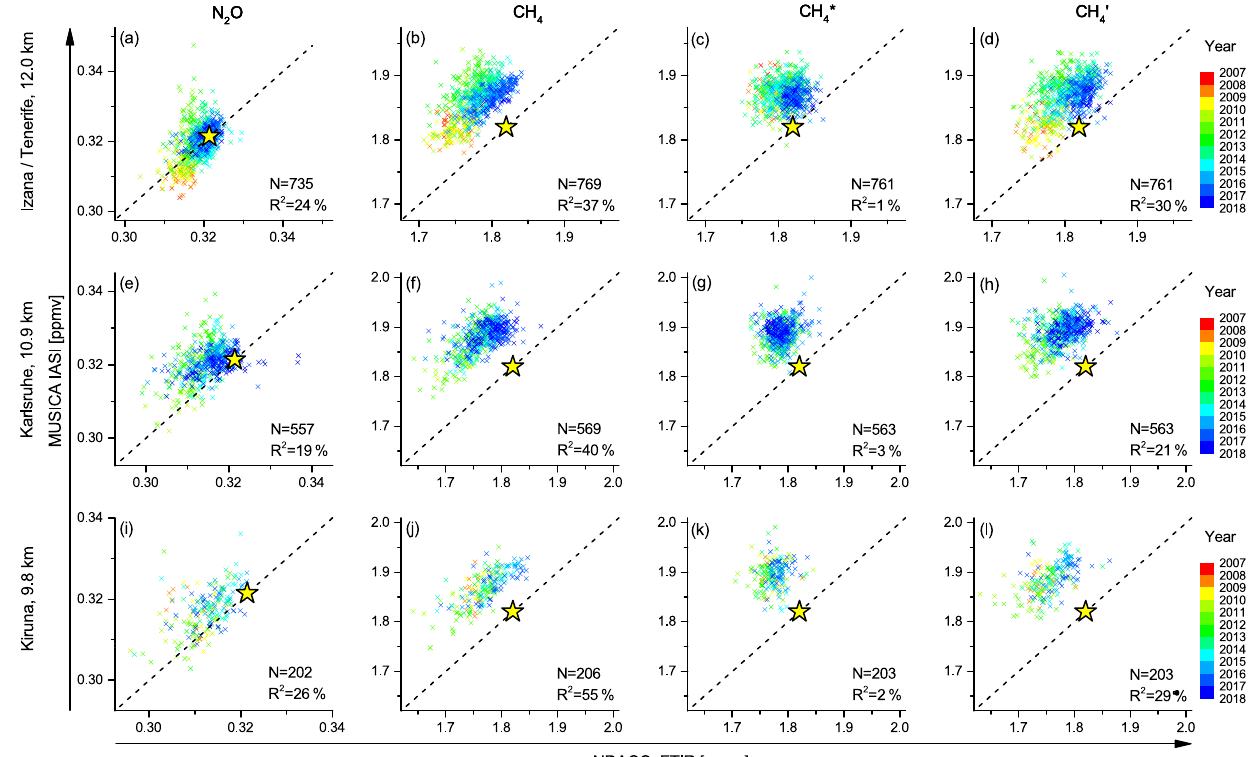
Figure 12. Same as Fig. 11, but for correlations at altitudes representing the UTLS regions.